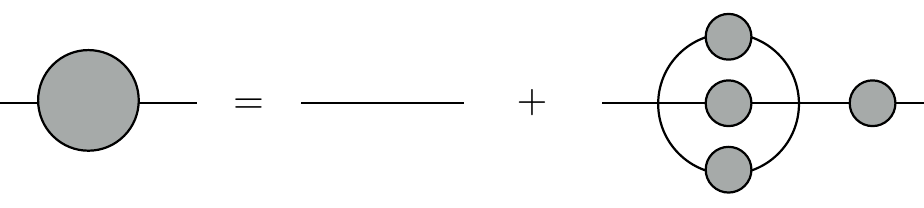
Figure 2 . Diagrammatic representation of the DSE. The line with the full ball represents the two-point function while the line alone represents the